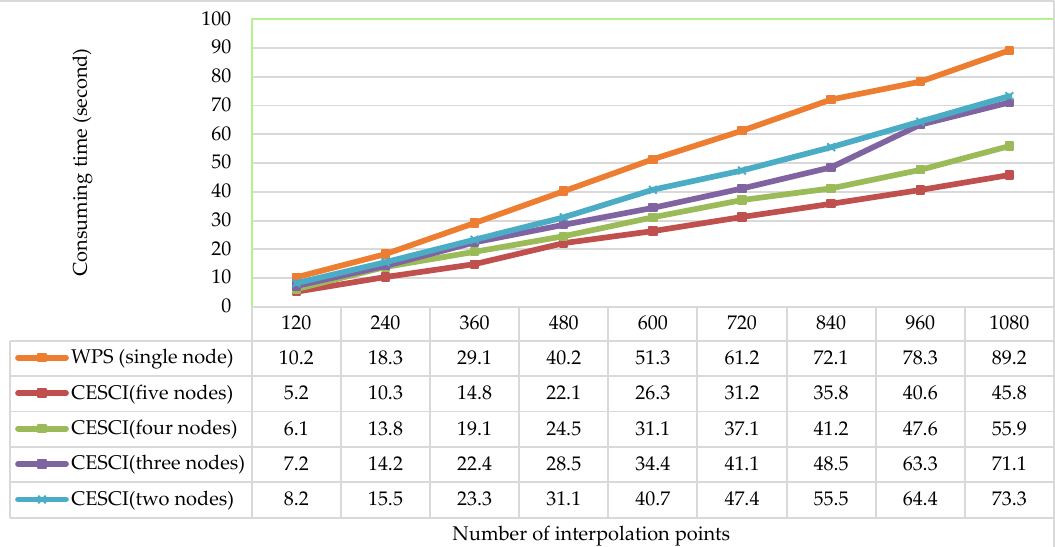
Figure 11. Time consumption of interpolation of different numbers of interpolation points using the WPS (single node), CESCI (five nodes), CESCI (four nodes), CESCI (three nodes), and CESCI (two nodes) methods.